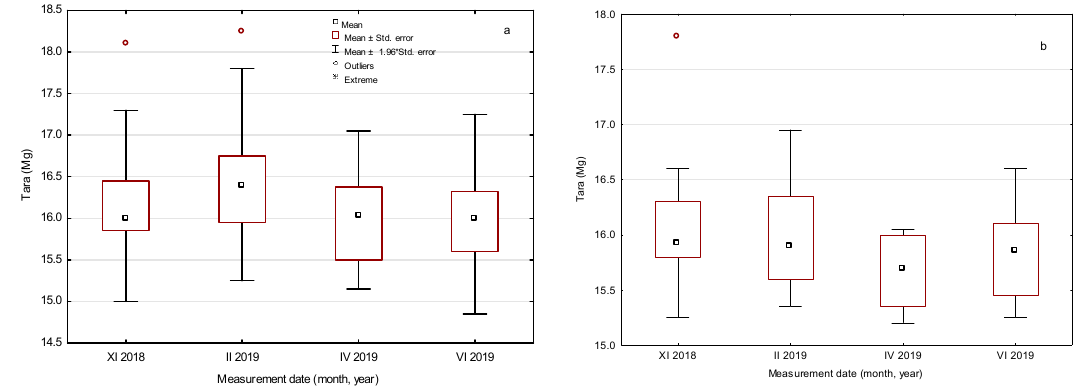
Figure 5. Comparison of tare values by measurement date for unit A wood chips ( a ); sawdust ( b ).